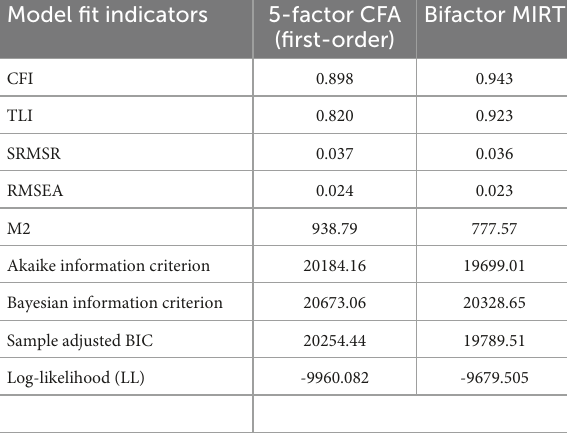
TABLE 4 Model fitting indicators for confirmatory and bifactor MIRT